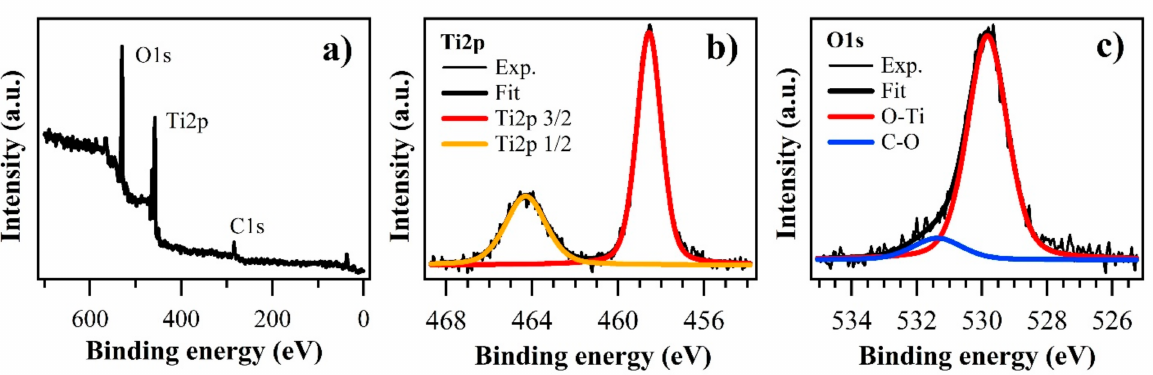
Figure 3. XPS analysis of TiO 2 H surface. Wide range spectrum ( a ), Ti2p ( b ) and O1s ( c ) core levels are shown, with details about peak